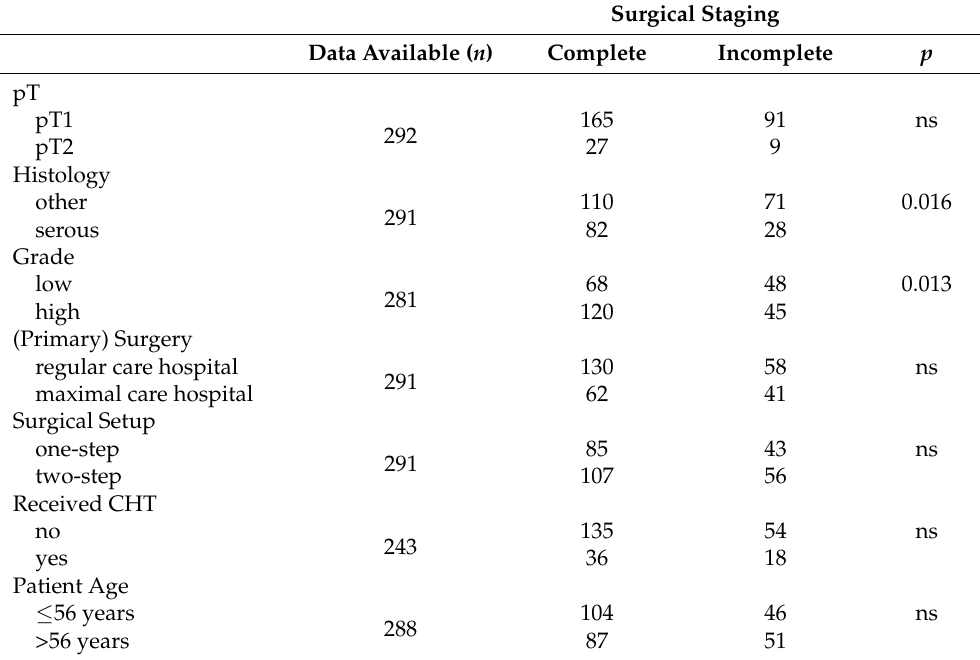
Table 2. Clinicopathological Characteristics of Patients with Complete vs. Incomplete Surgical Staging (stages pT1-pT2a